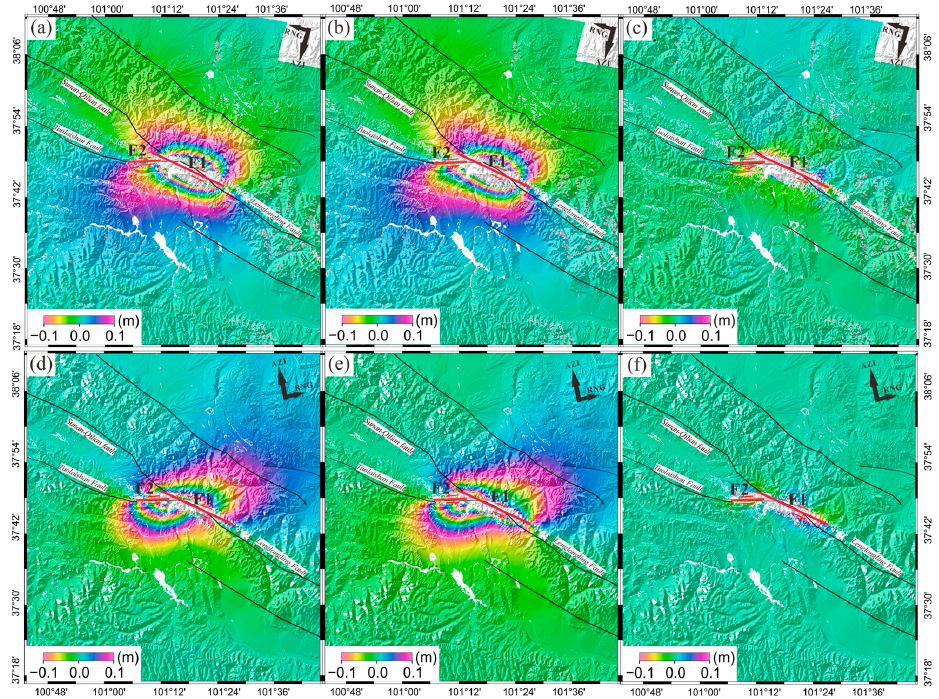
Figure 7. Coseismic deformation fields of the 2022 Menyuan earthquake. ( a , d ) show the observed coseismic deformation for Descending Track 33 and Ascending Track 128, respectively. ( b , e ) represent simulated deformation maps. ( c , f ) represent the residuals. F1: rupturing segment of the LLLF, F2: rupturing segment of the TLSF.